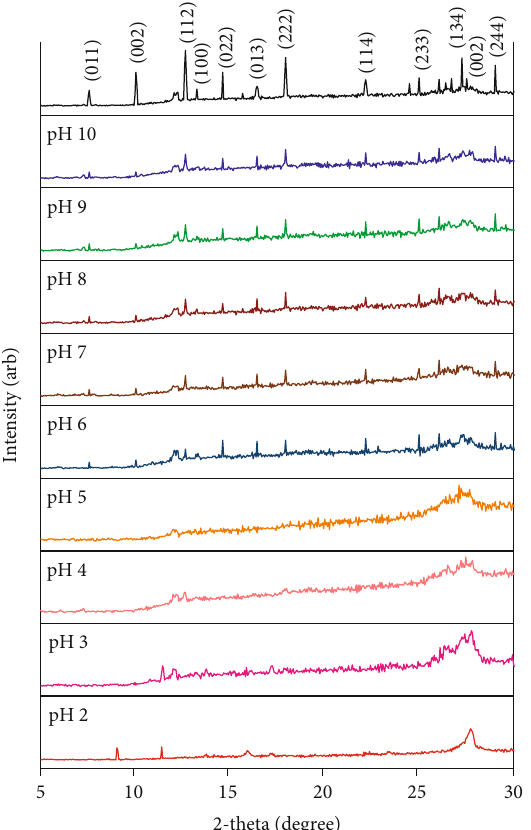
Figure 7: XRD patterns of (5/5)ZIF-67/ g -C